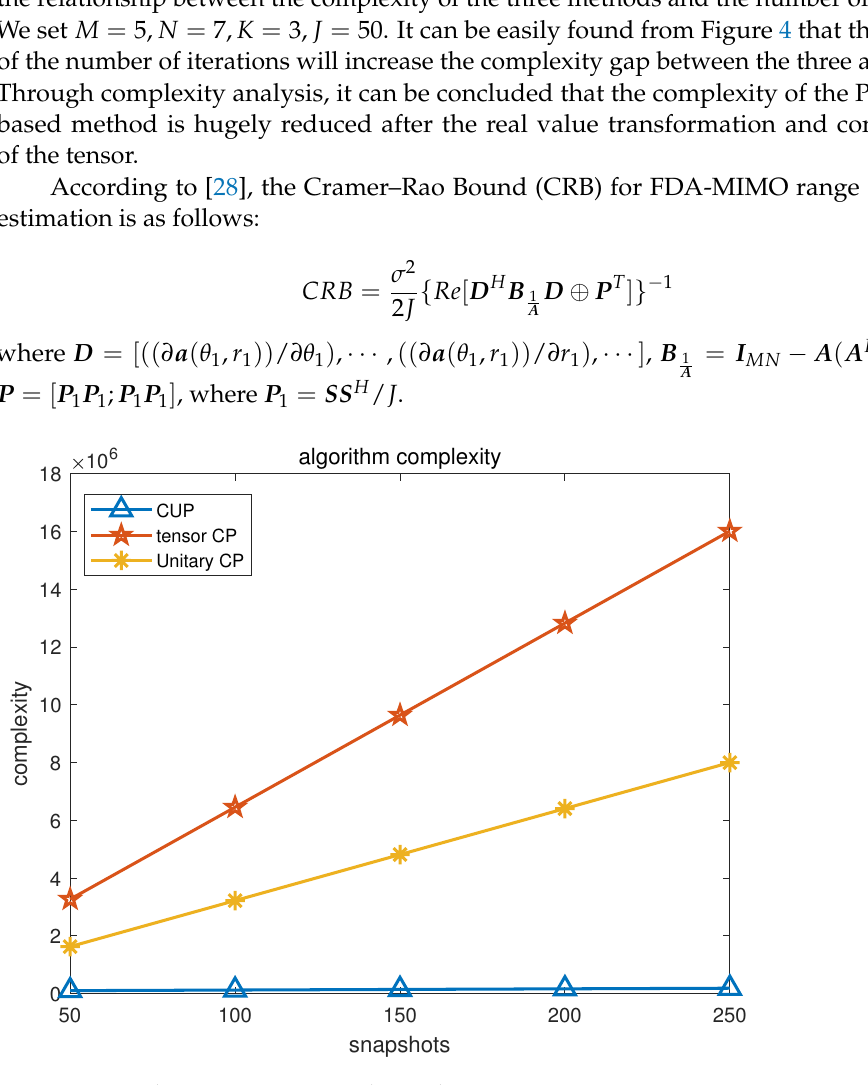
Figure 3. Complexity comparison and